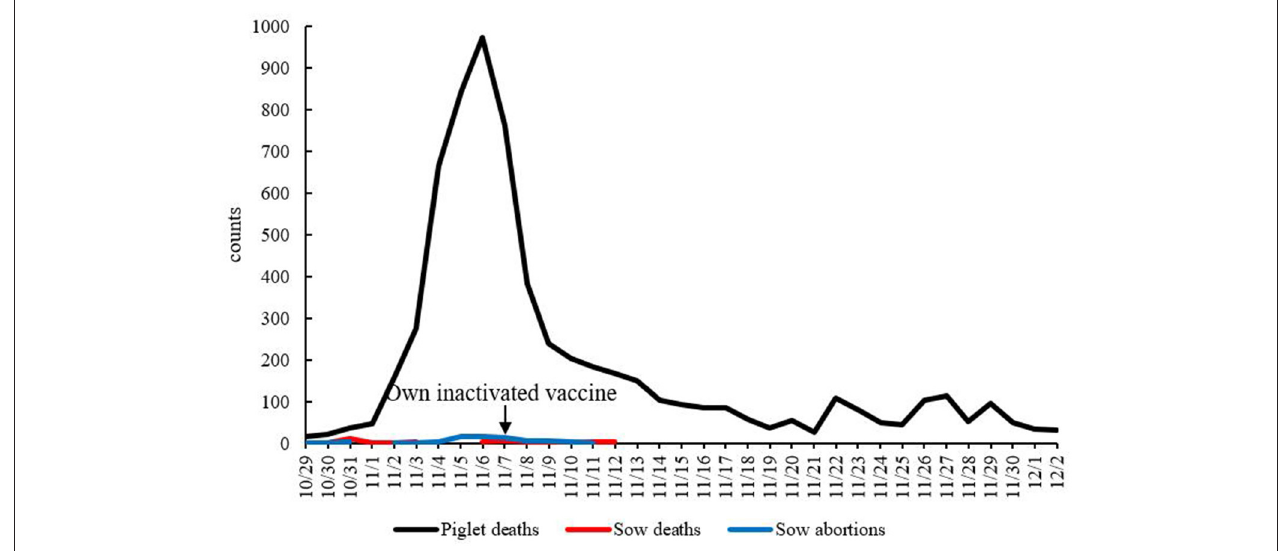
FIGURE 1 | Time–mortality dynamic curve. The x -axis shows time, and the y -axis shows the number of died pigs. The arrow is the time for the farm to inject its own inactivated